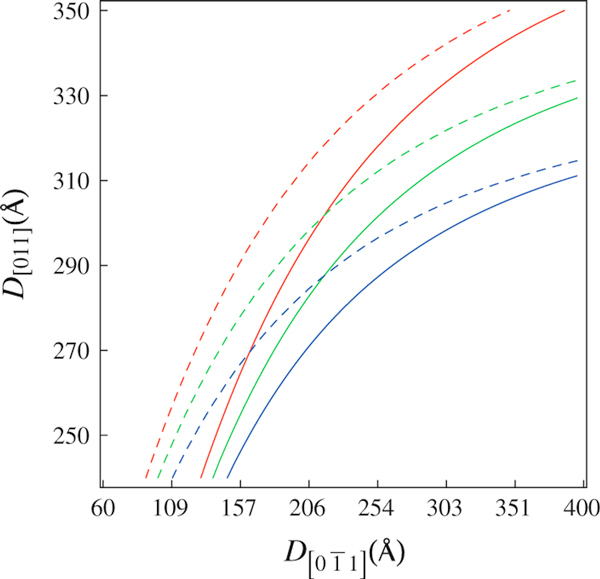
Oscillator strength contours fulfilling Pol[011]=Pol[01¯1] for correlated dots with inter-dot distances d = 160 Å (solid line) and 330 Å (dashed line) and strain order factors ε|| = –0.3% (red), ε|| = –0.4% (green) and ε|| = –0.5% (blue).